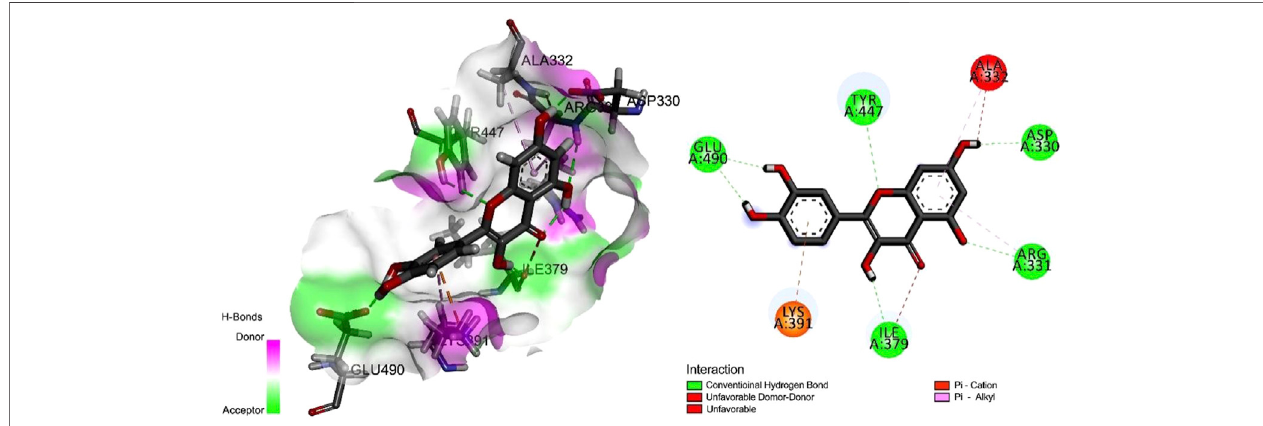
FIGURE 4 | The molecular docking results of the ClfB protein and QEN, which showed that the QEN molecule form fi ve H-bonds with the fi ve amino acid residues (D330, R331, I379, Y447, and E490) of ClfB with a binding free energy of − 7.7 Kcal/mol.